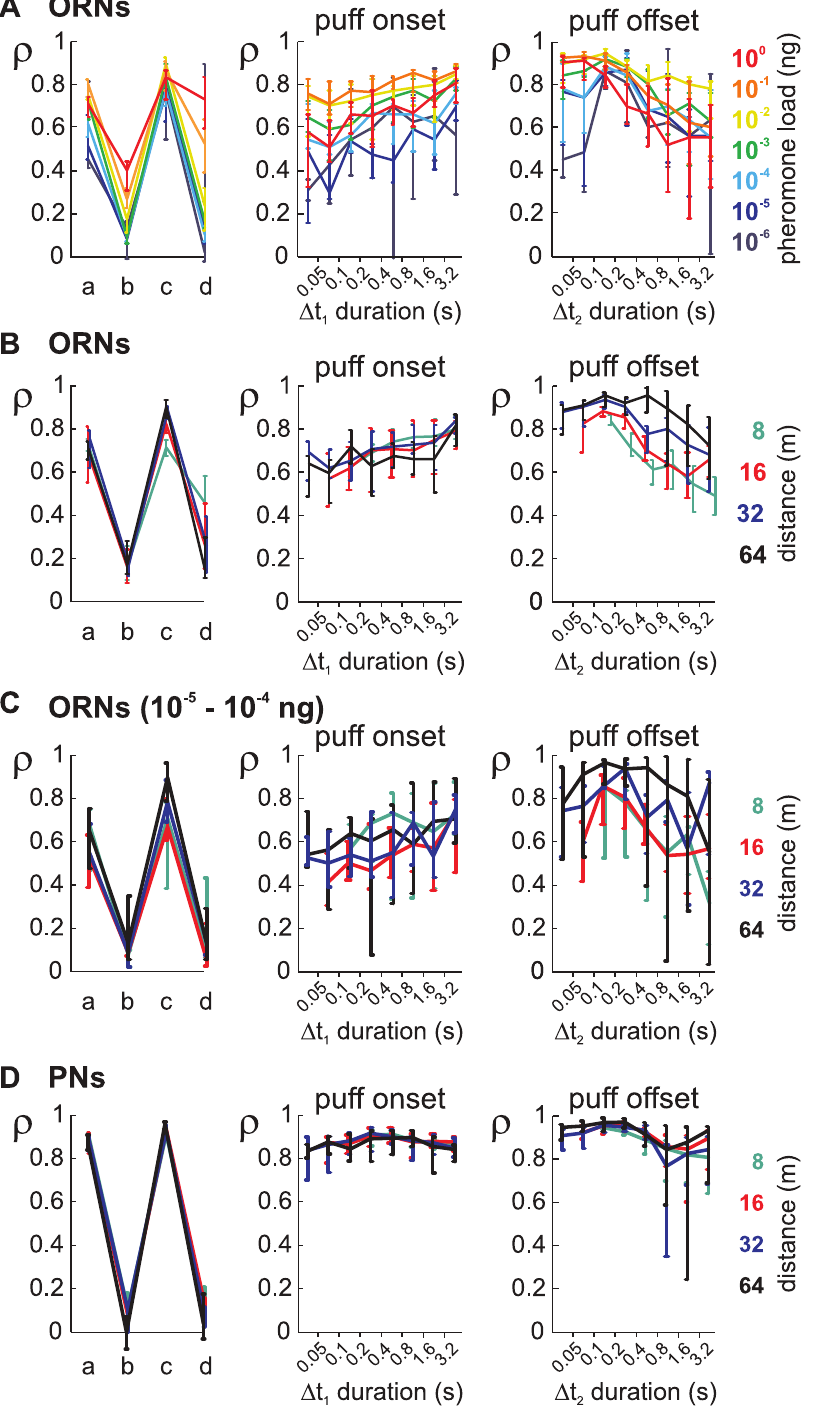
Fig 9. Neuronal coding of time sub-regions of turbulent stimuli analyzed as a function of pheromone load and distance. (A) Analysis of olfactory coding in ORNs as a function of pheromoneload. Left: coding duringthe 4 sub-regions describedin Fig 8A analyzedfor each pheromoneload using the same analysisas in Fig 8E. Plot shows median values of correlation coefficients and bootstrapconfidenceinterval. Colors code for pheromone load. Middle and right: same analysisas in Fig 8G and 8H, but ORN data are subdivided in different pheromoneloads. Middle: codingof onset of puffs depends on time delay from the end of